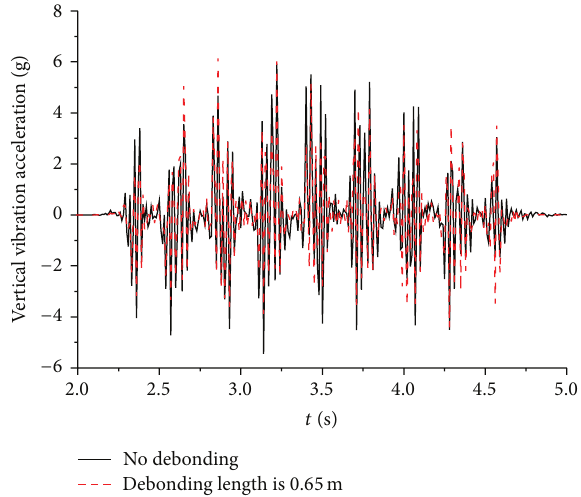
Figure 8: Time history of vertical vibration acceleration of